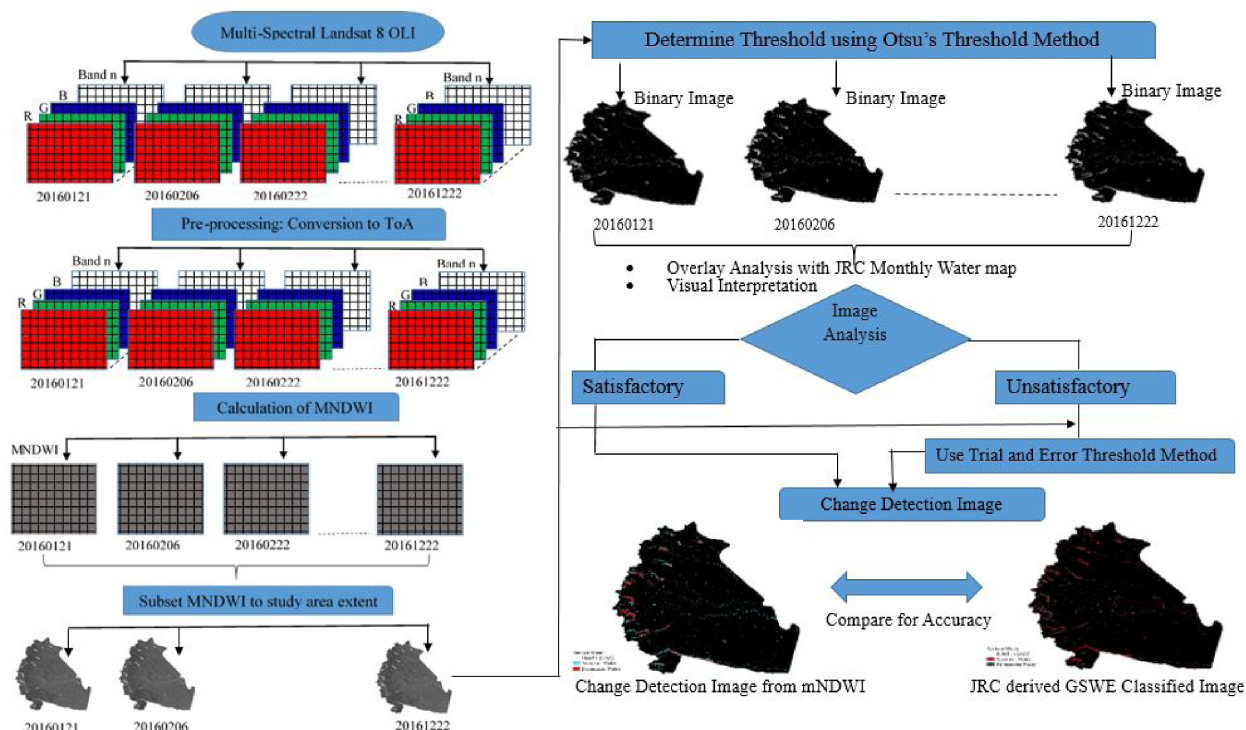
Figure 2. Flow chart of the methodology used. OLI, Operational Land Imager; ToA, Top of Atmosphere; MNDWI, Modified Normalized Difference Water Index; JRC, Joint Research Centre; GSWE, Global Surface Water Explorer. Landsat 8 images courtesy of the U.S. Geological Survey.